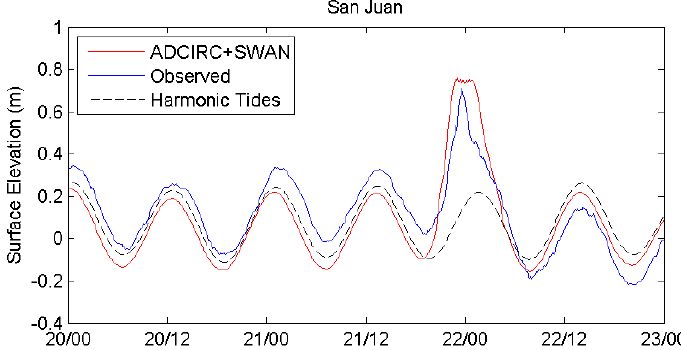
Figure 8. Observed (blue line) and ADCIRC + SWAN (red line) water surface levels at San Juan during Hurricane Georges. The dashed line represents the ADCIRC tide-only water level as a reference. The observed values were obtained from the NOAA 9755371 monitoring station at the San Juan Harbor. The plotted period is from 20 September 1998 0:00 UTC to 23 September 1998 0:00 UTC.